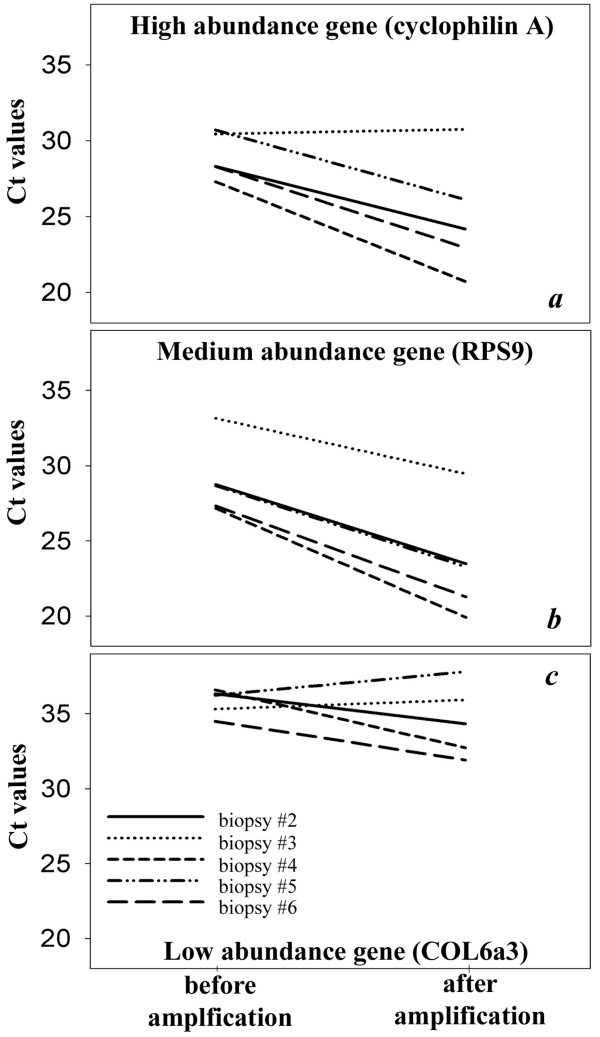
Quantitative real-time PCR (qPCR) of biopsy RNA before and after amplification using a high (cyclophilin A), medium (ribosomal protein S9, RPS9) and low (collagen VI alpha 3, COL6a3) abundance transcript. Material for the 'before amplification' qPCR was obtained from cDNA synthesis from total biopsy RNA; material for the 'after amplification' qPCR was obtained from cDNA synthesis from first round cRNA. After amplification, biopsy #3 yielded aberrant Ct values for all 3 genes; biopsy #5 only for COL6a3.